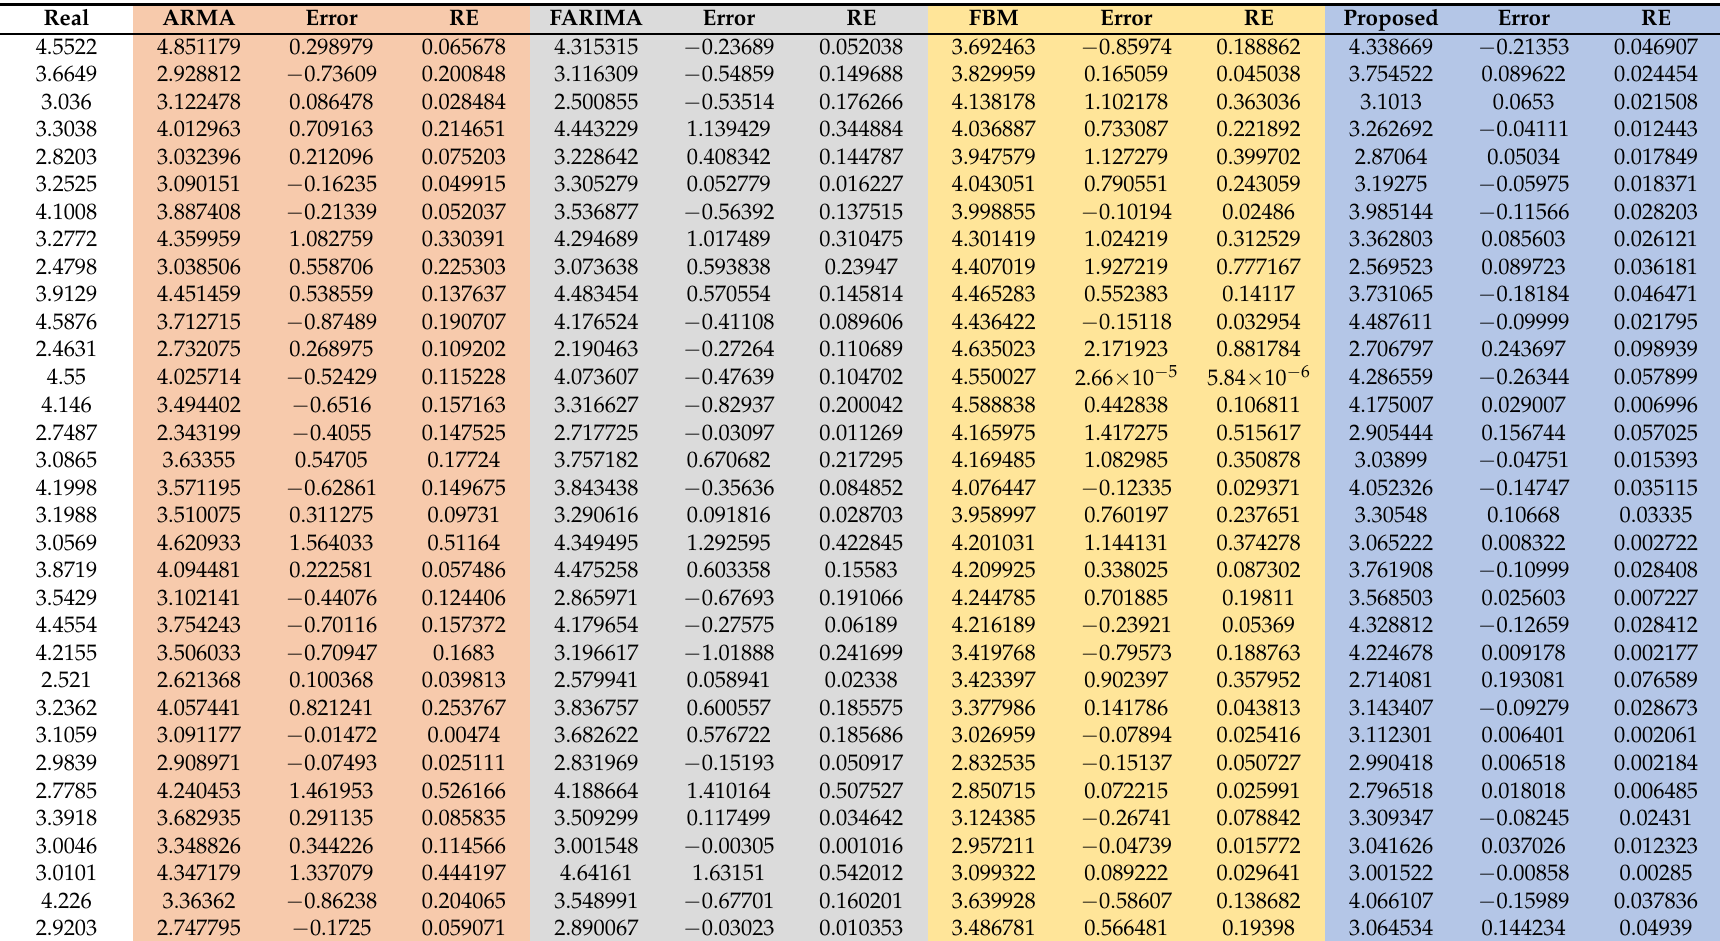
Table A1. Predicting results using different quantitative parameters for case 1 (The EVI time series with weak LRD